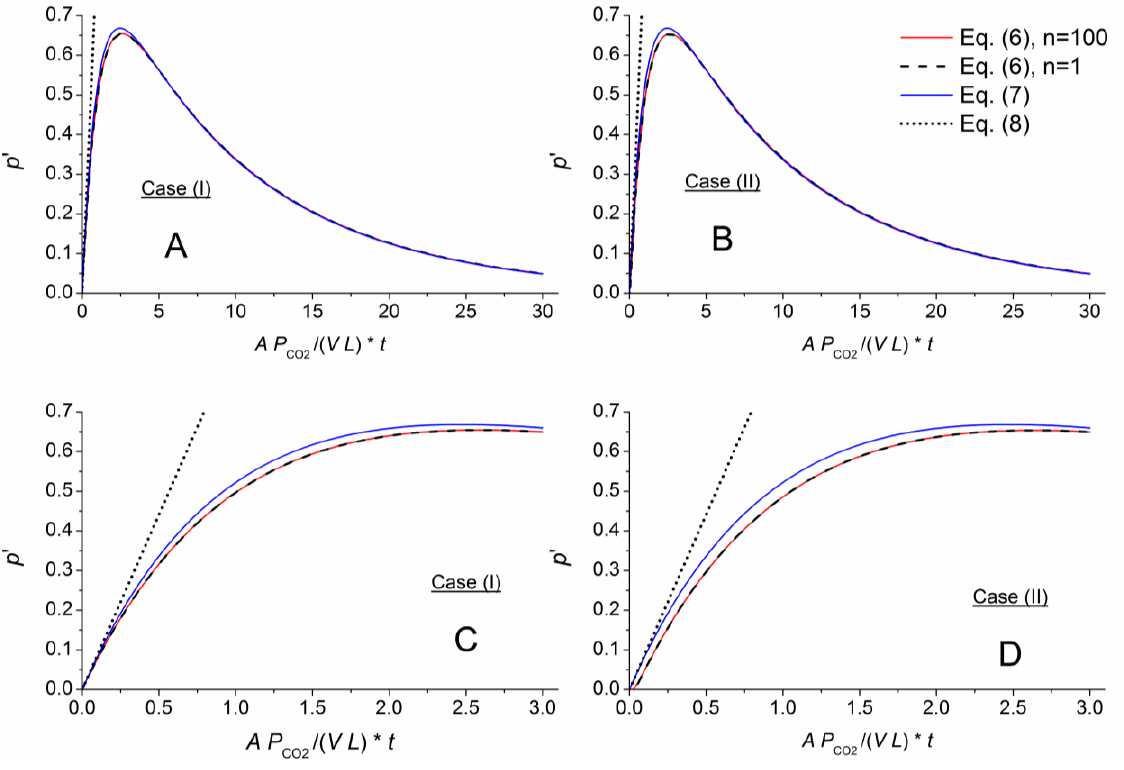
Table 4. Numerical eigenvalues and coefficients, j